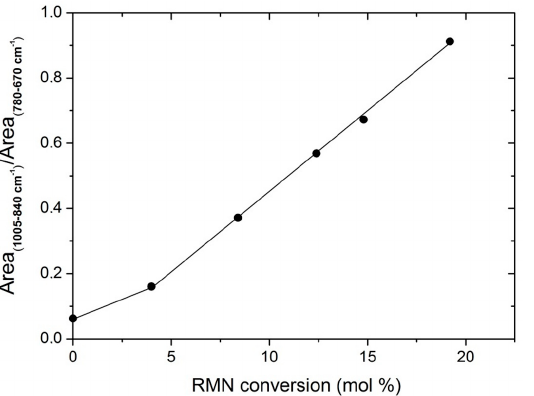
Figure 4. Calibration curve of the comonomer content estimated by FTIR and NMR from all the polymers.